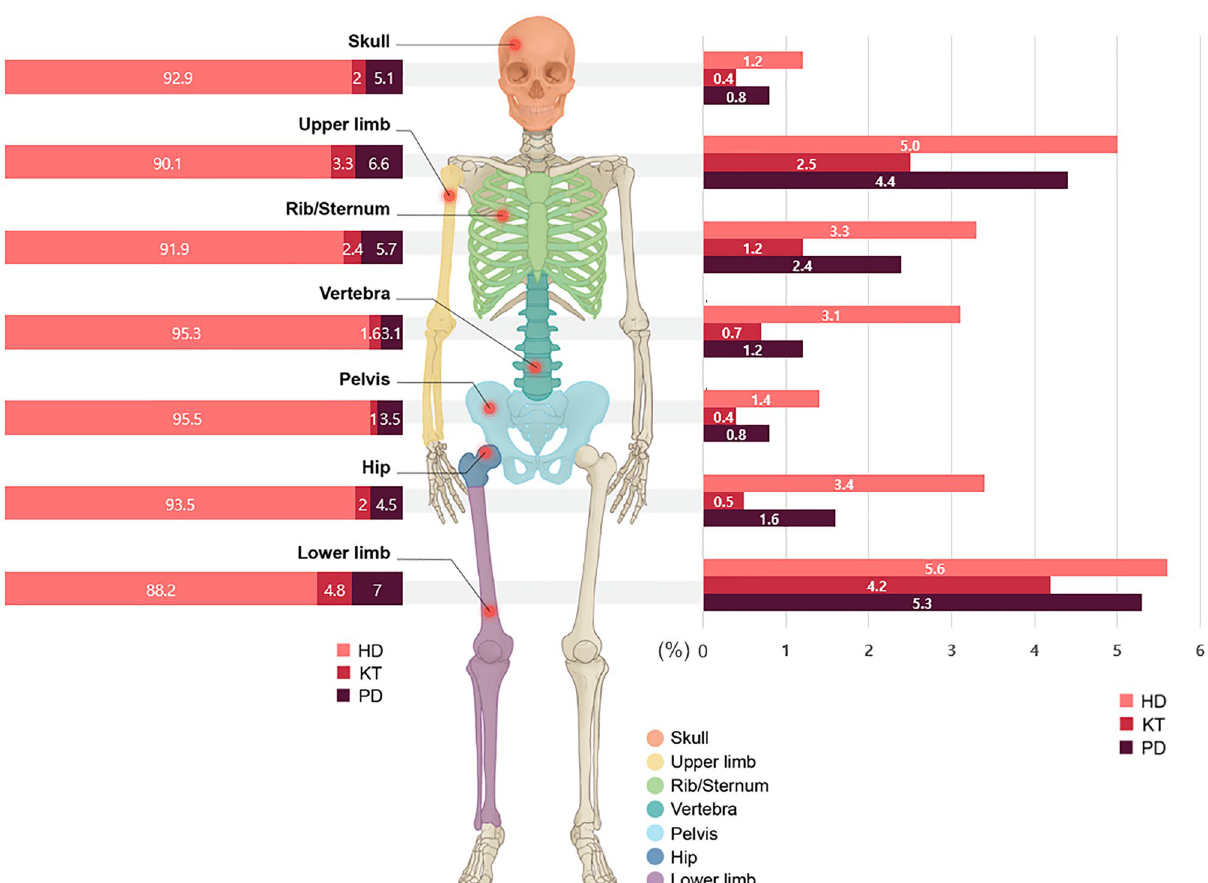
Figure 2. Proportion (%) of specific kidney replacement therapy modality used at each fracture site (left panel) and the frequency (%) of fracture based on anatomical site according to kidney replacement therapy (right panel). HD hemodialysis, KT kidney transplant, PD peritoneal